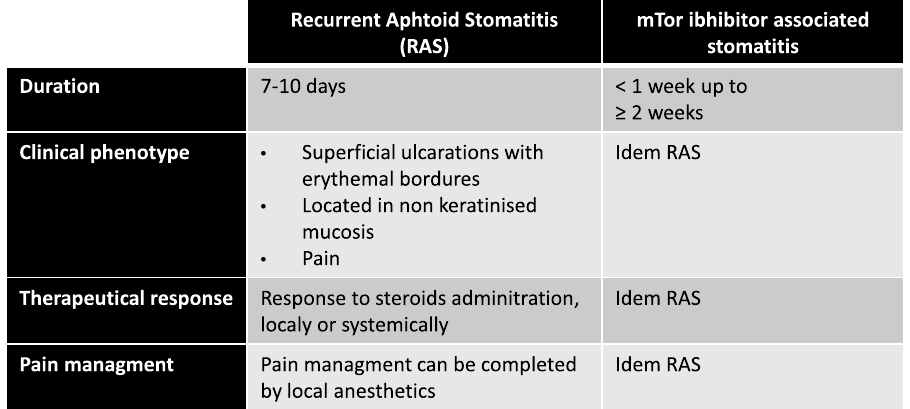
Fig. 3. Comparison between clinical characteristics of recurrent aphtoid stomatitis and mammalian target of rapamycin-inhibitor-associated